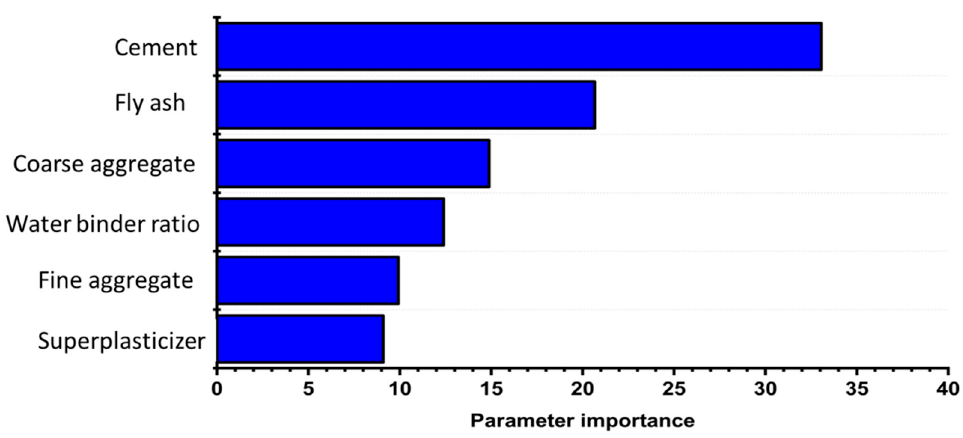
Figure 6. Features importance in strength prediction.